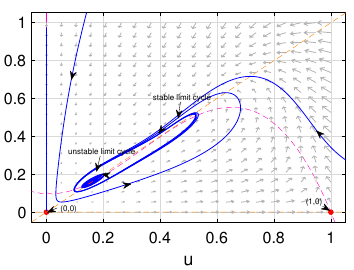
Figure 9. For A = 0 . 0275 , B = 0 . 0075 , S = 0 . 65 and Q = 0 . 2875, there exists a non-infinitesimal limit cycle surrounded three positive equilibrium points, one of them ( u e 1 ,u e 1 ) to the left, is an attractor focus encircled by a unstable cycle. The point (0 , 0) is a non-hyperbolic saddle and (1 , 0) is a hyperbolic saddle.